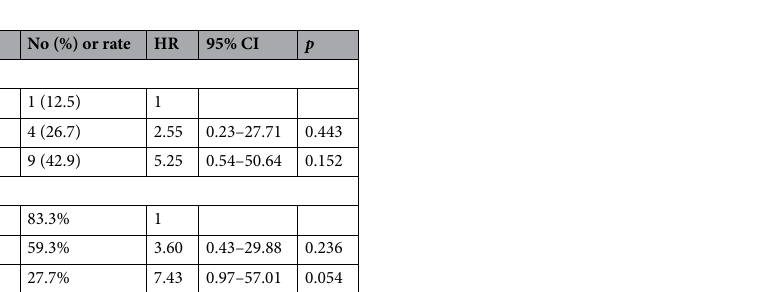
Figure 2. ( a ) Kaplan–Meier curves of distant metastasis (DM)-free survival according to PNI/LVI status. The 2-year DM-free survival rates were 90.1%, 83.6%, and 57.2% in PNI/LVI double-negative, single-positive and double-positive group, respectively. ( b ) Kaplan–Meier curves of disease-specific survival according to PNI/LVI status.